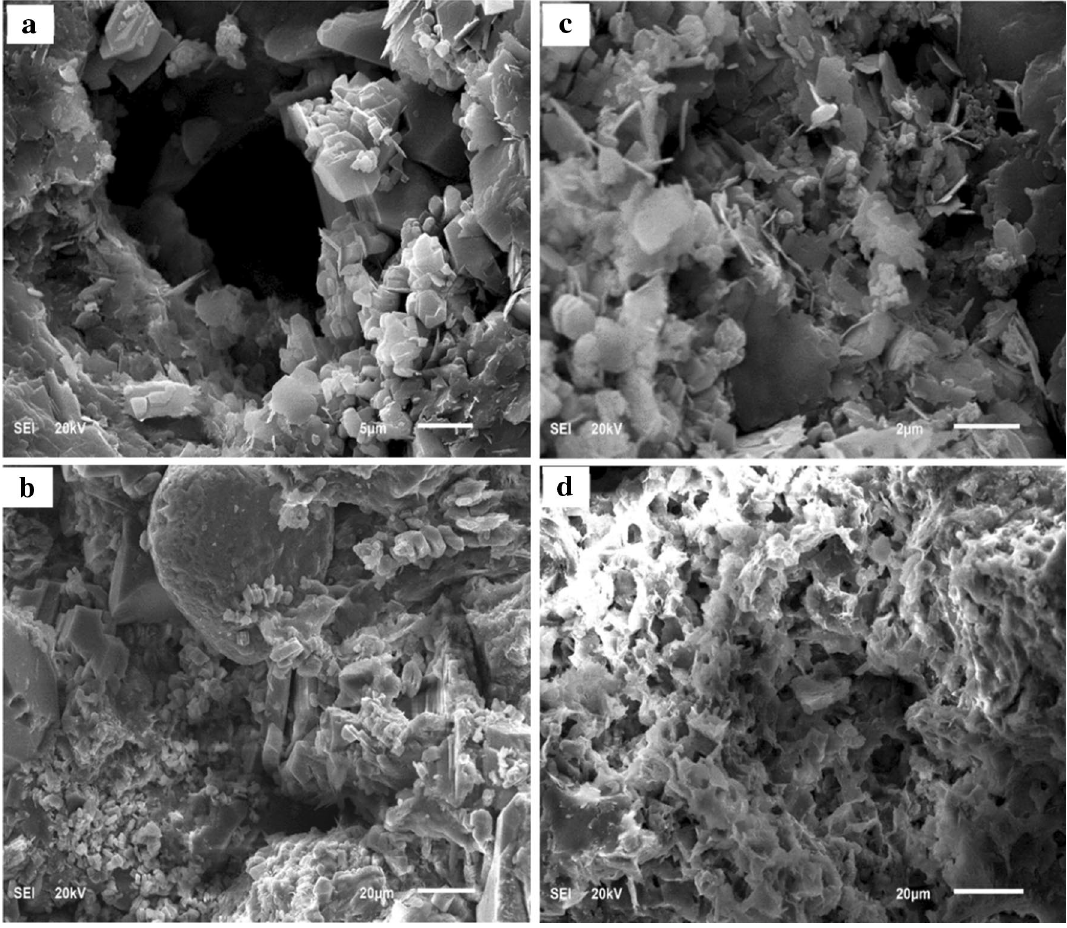
Fig. 10 SEM of Bandera Grey sandstone cores a BR1 before water flooding, b BR1 after water flooding, c BR2 before HCl flooding and d BR2 after HCl